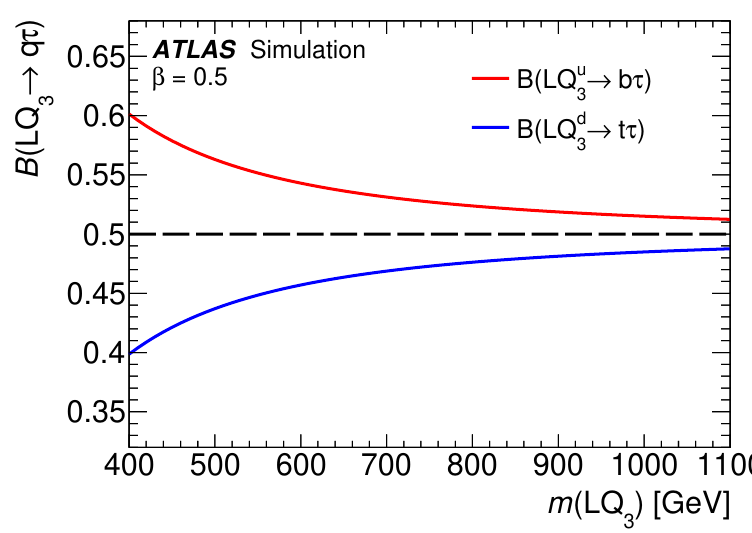
Figure 2 . Branching ratio into charged leptons for (cid:12) = 0 : 5 and di(cid:11)erent LQ masses for LQ u ! b(cid:28)=t(cid:23) and LQ d ! t(cid:28)=b(cid:23) 3